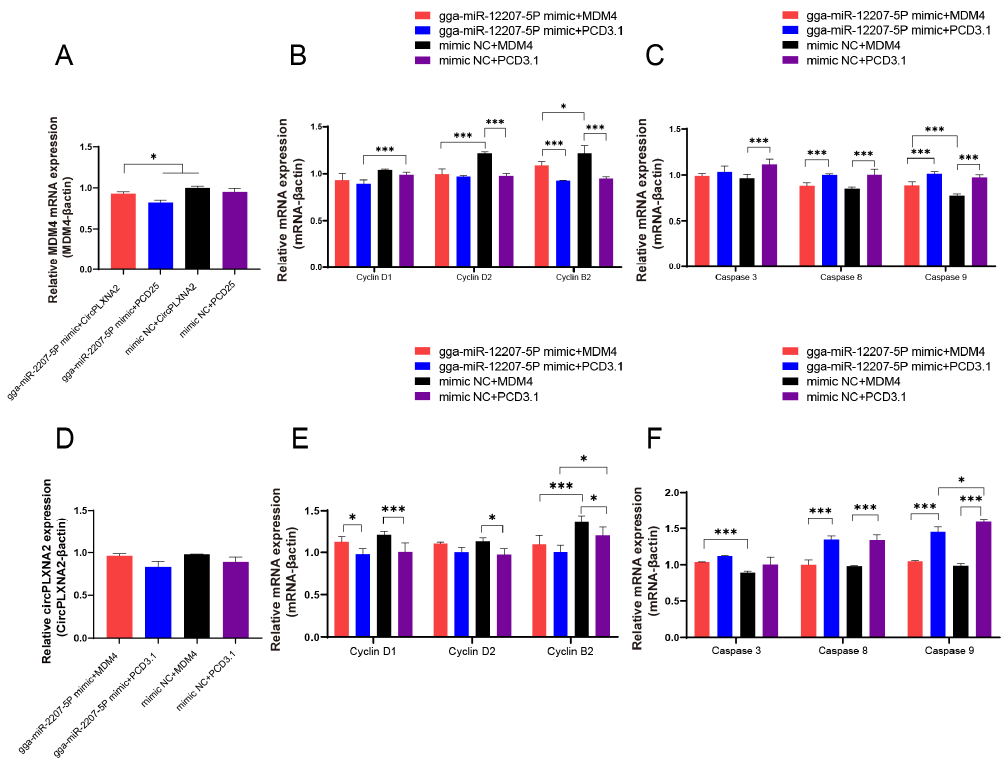
Figure 7. CircPLXNA2 regulates MDM4 by competitive adsorption of gga ‐ miR ‐ 12207 ‐ 5P to affect the proliferation and apoptosis of myoblasts. ( A ) The mRNA expression level of MDM4 after co ‐ transfection of gga ‐ miR ‐ 12207 ‐ 5P mimic and circPLXNA2 in myoblasts. ( B ) The mRNA expression levels of cyclin D1, cyclin D2, and cyclin B2 after co ‐ transfection of gga ‐ miR ‐ 12207 ‐ 5P mimic and circPLXNA2 in myoblasts. ( C ) The mRNA expression levels of caspase 3, caspase 8, and caspase 9 after co ‐ transfection of gga ‐ miR ‐ 12207 ‐ 5P mimic and circPLXNA2 in myoblasts. ( D ) Expression level of circPLXNA2 after co ‐ transfection of gga ‐ miR ‐ 12207 ‐ 5P mimic and MDM4 in myoblasts. ( E ) qRT ‐ PCR results of cyclin D1, cyclin D2, and cyclin B2 after gga ‐ miR ‐ 12207 ‐ 5P mimic and MDM4 co ‐ transfection. ( F ) qRT ‐ PCR results of caspase 3, caspase 8, and caspase 9 after gga ‐ miR ‐ 12207 ‐ 5P mimic and MDM4 co ‐ transfection. (* p < 0.05 and *** p < 0.001)